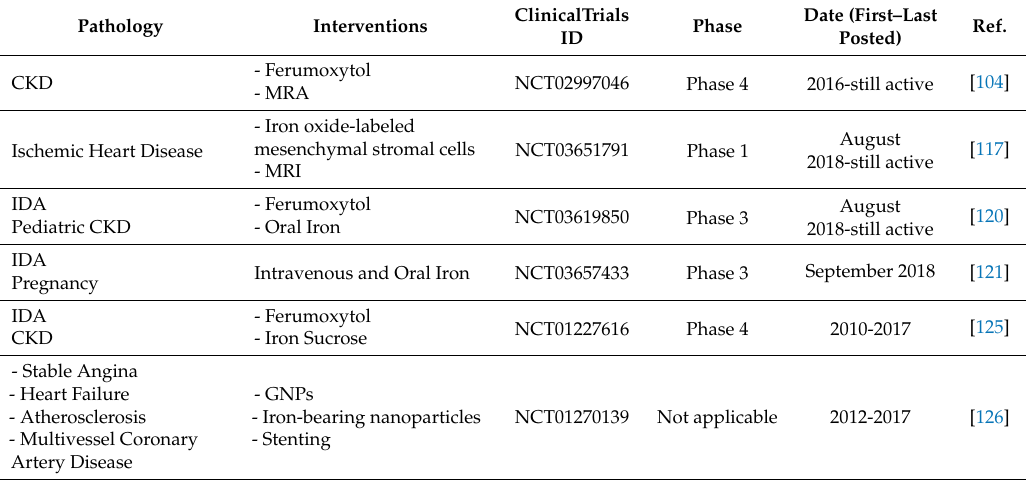
Table 3. Current clinical trials of thermosensitive nanomaterials for treatment of various diseases available on clinicaltrials.gov until November